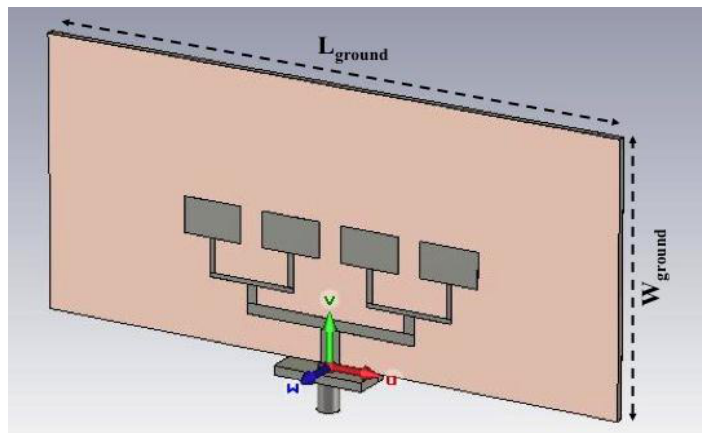
Figure 9. Schematic representation of the feeding network line.